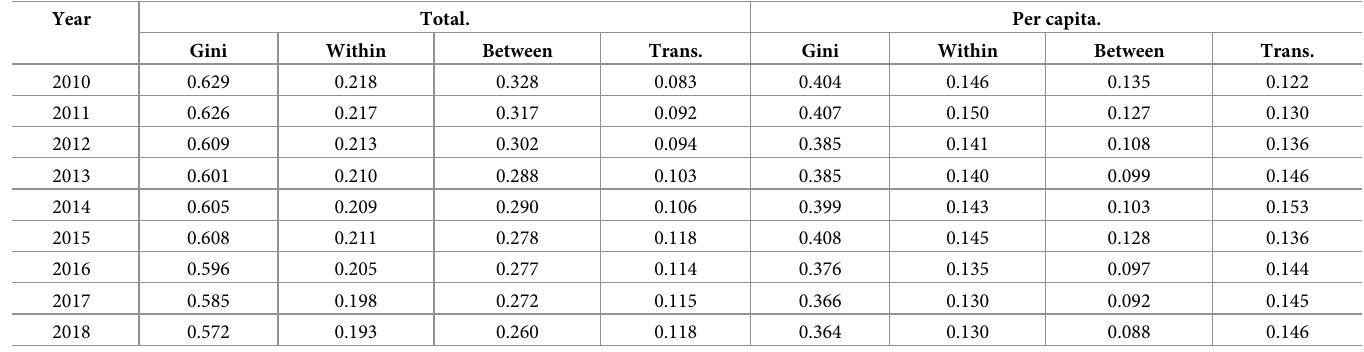
Table 1. The result of the Gini coefficient and its decomposition. Year Total. Per capita. Gini Within Between Trans. Gini Within Between Trans.